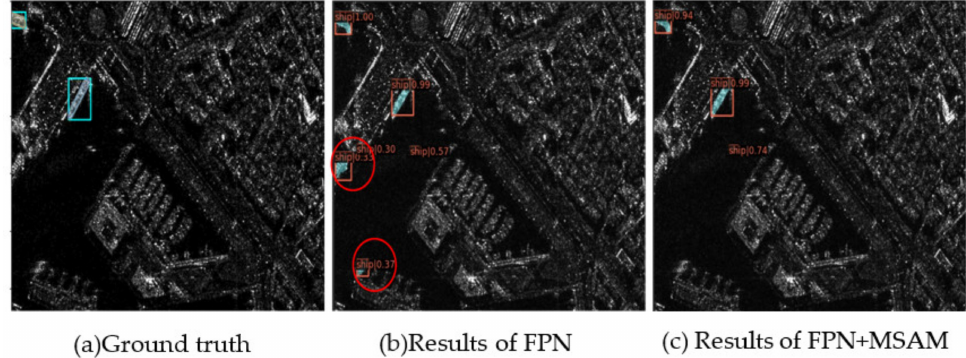
Figure 11. Comparison of performance of FPN and FPN + MSAM. ( a ) Ground truth. ( b ) The result of FPN. The red circles indicate the false detection by FPN. ( c ) The result of FPN + MSAM. In a complex background, FPN falsely recognizes many inshore buildings as ships, which can be avoided by the use of